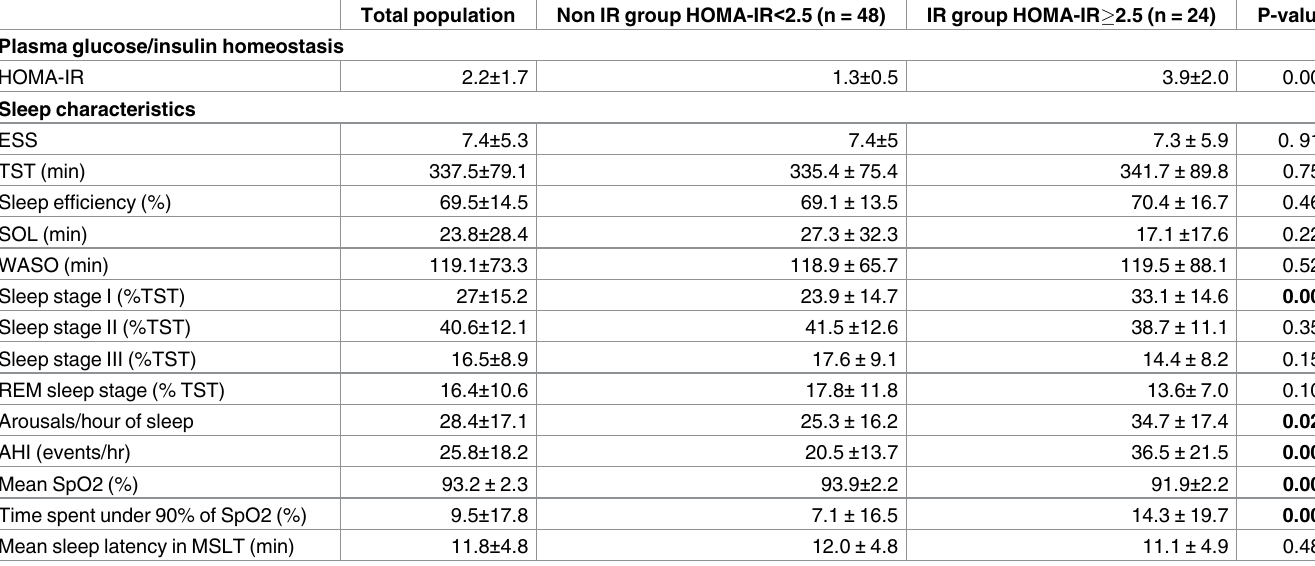
Table 2. Sleep parameters in patients with and without insulin